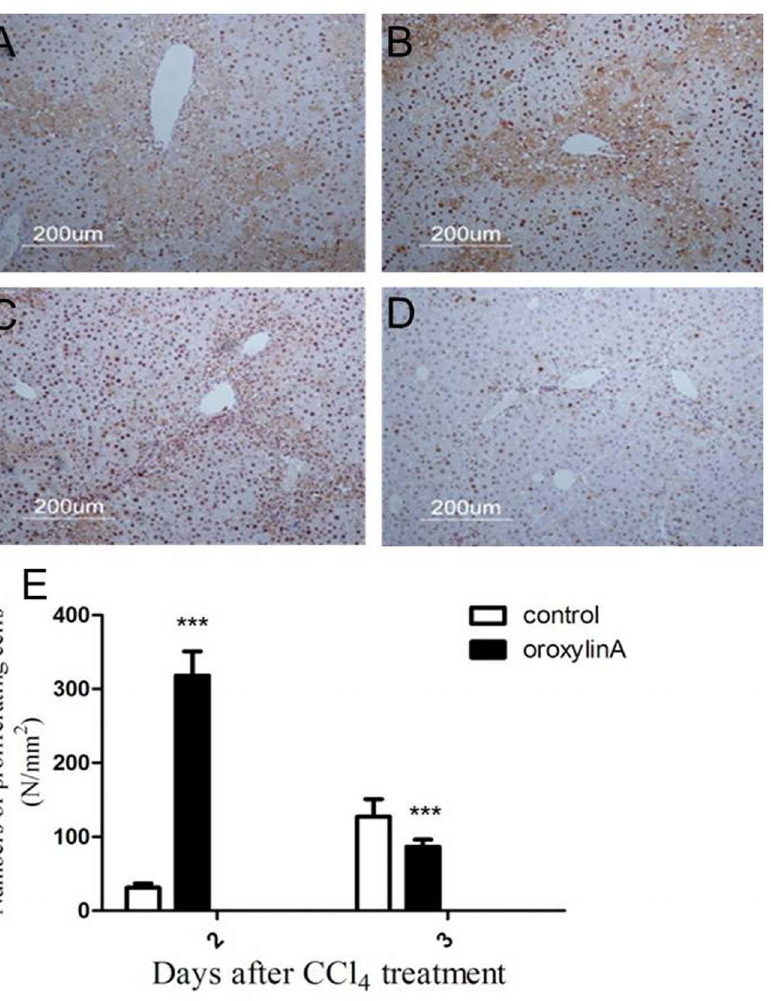
Figure 3. Oroxylin A promotes hepatic cell proliferation in CCl 4 -induced acute liver injury mice. Immunohistochemical staining for proliferating cell nuclear antigen (PCNA) was carried out as previously described. PCNA staining liver sections in the mice without (A) or with oroxylin A administration (B) at day 2 after CCl 4 treatment. The control group showed few PCNA + hepatocytes in centrilobular areas, but oroxylin A administration demonstrated numerous PCNA + hepatocytes surrounding the edge of hepatocellular necrosis. PCNA staining liver sections from the control (C) and oroxylin A administration (D) at day 3 after CCl 4 treatment. The control shows much more numbers of PCNA + cells compared to oroxylin administration in the view. (E) PCNA + cells in the liver sections were measured. At least six 12 mm 2 tissue sections were counted for each mouse. Values represent mean 6 SE (n=6). (*), (**), and (***) for P , 0.05, P , 0.01 and P , 0.001 respectively.